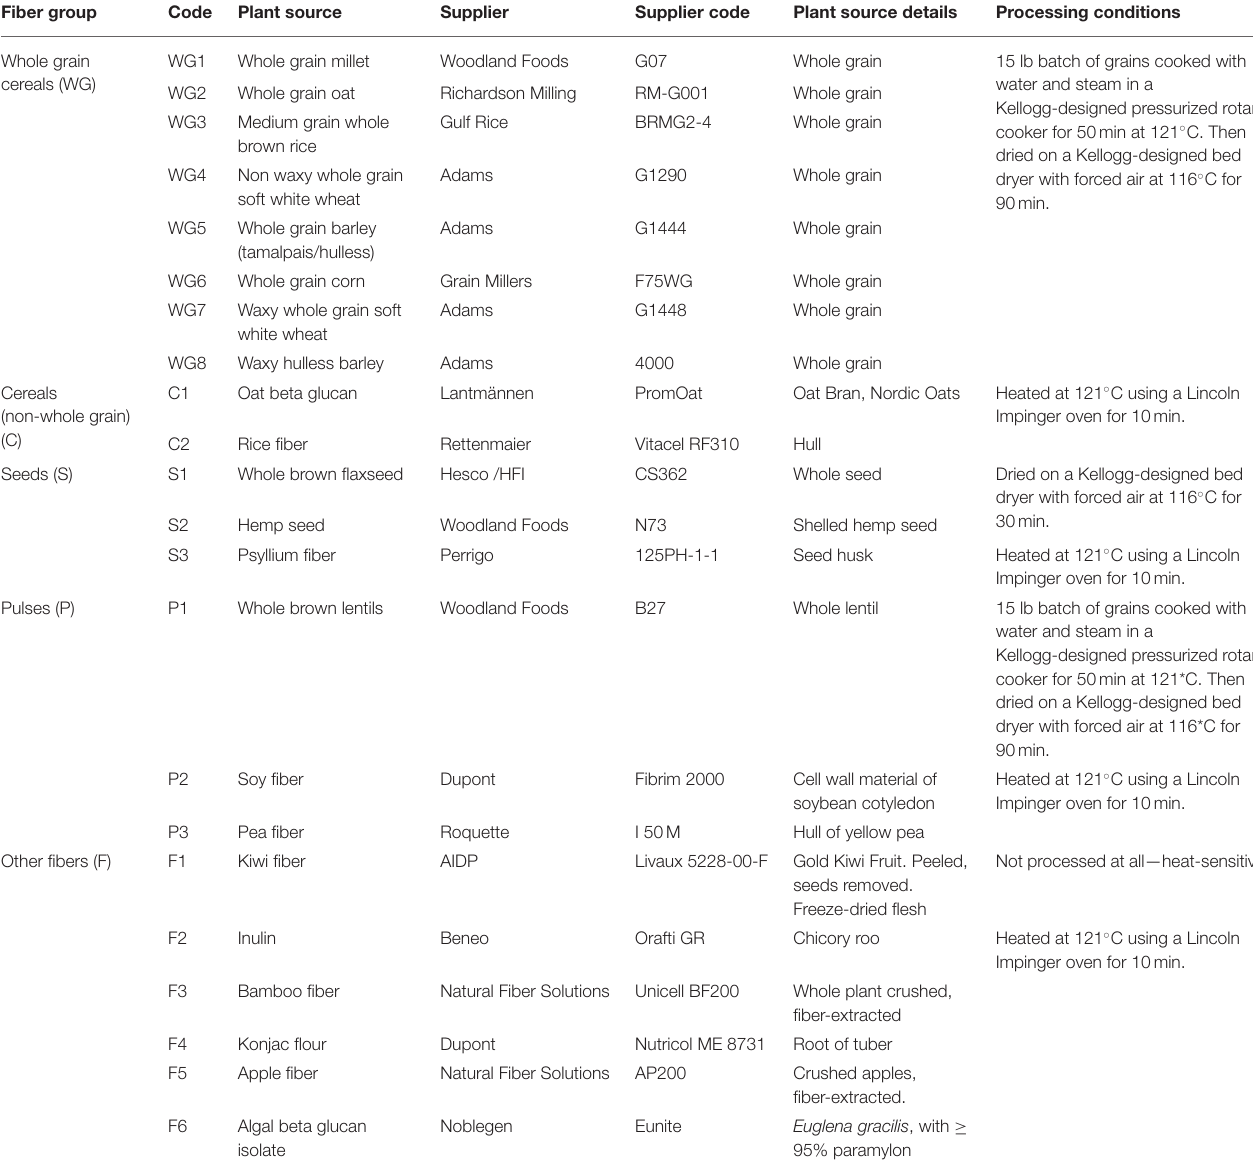
TABLE 1 | Description of products used in this